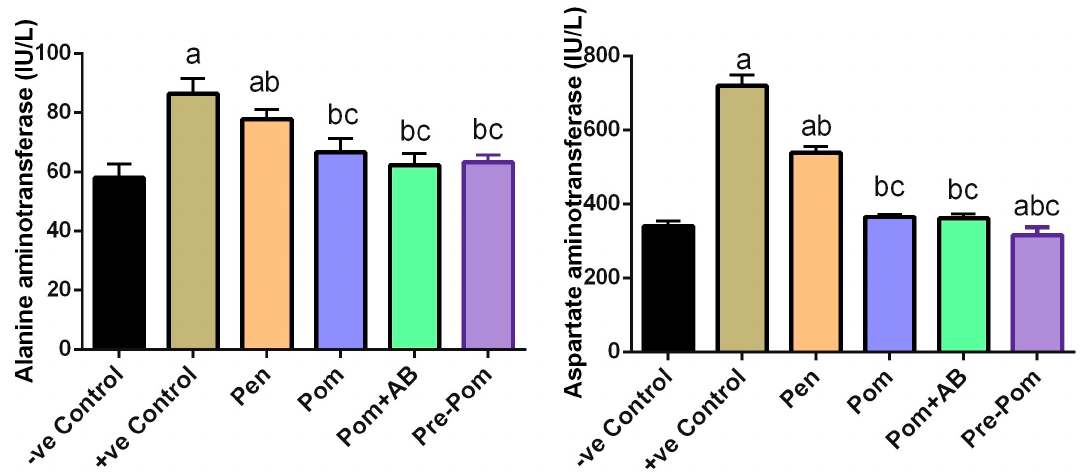
Figure 4. Effect of pomegranate juice supplementation and Pentostam treatment on the activities of serum transaminases in the control and experimental groups four weeks after infection. Values are mean ± SEM (n = 10). a p < 0.05, significant change compared to –ve Control group; b p < 0.05, significant change compared to +ve Control group; c p < 0.05, significant change compared to Pentostam group.